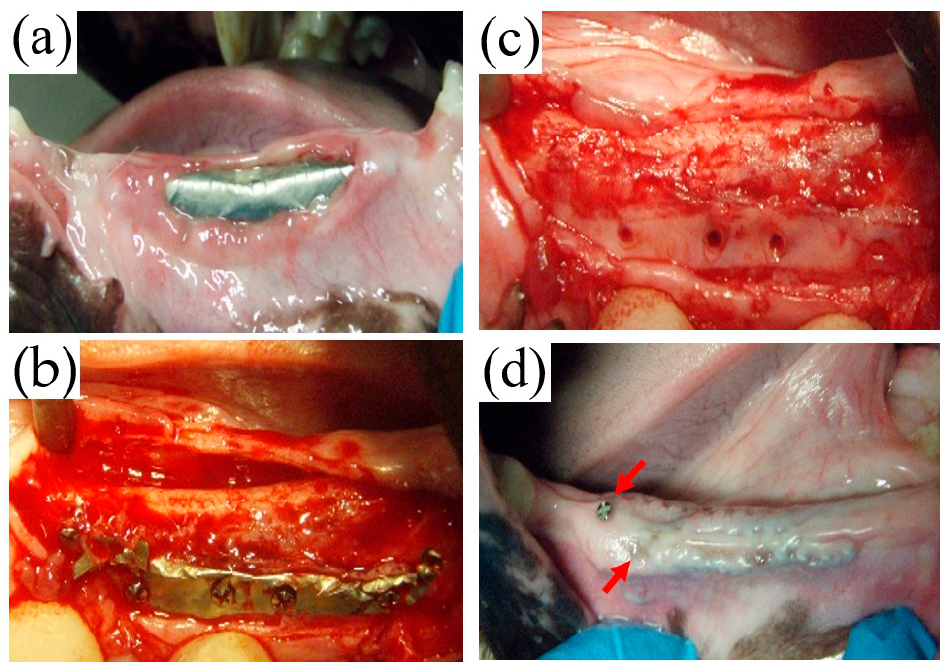
Figure 6. Macroscopic observation of the membrane exposure. ( a ) The membrane exposure in the TiHM group. The membrane exposure was found on the alveolar crest at 3 weeks postoperatively. ( b ) In the same site as (a), the membrane was extracted at 9 weeks postoperatively. ( c ) In the same site as (b), after removing the granulation tissue, the new bone was found beneath the tissue. ( d ) The membrane exposure in the UFMP group. The secured screw and the surrounding membrane exposure were found on the alveolar crest at 8 weeks postoperatively (red arrows). However, the removal was not required because the exposures were not changed.